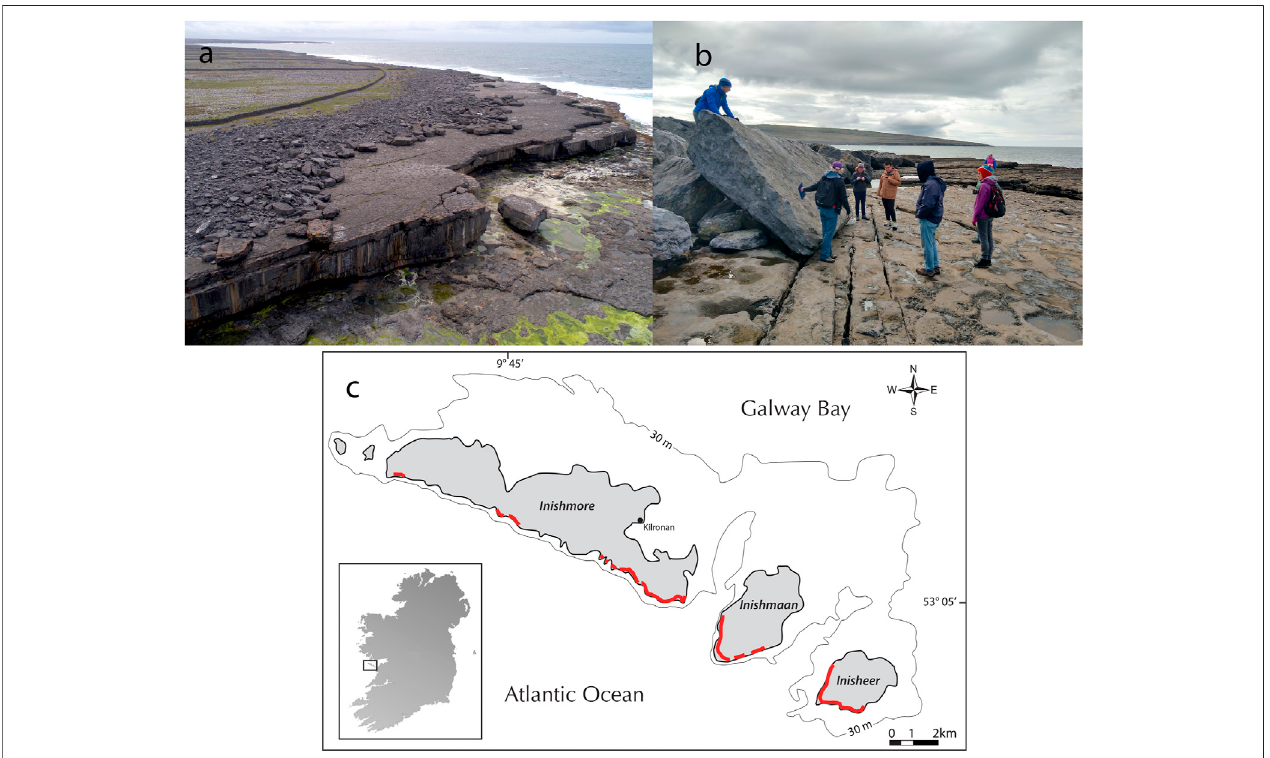
FIGURE 1 | Examples of CBD in Western Ireland. (A) linear boulder ridge (12 – 15 m elevation above high water and 50 – 60 m inland) on Inishmore, Aran Islands: a number of boulders in this ridge were relocated during recent storms; and the 620 t megagravel block on the lower platform (5 m elevation and 30 m inland) was also moved; (B) Boulder ridge face (4.5 m elevation and 17 m inland) on mainland (County Clare), east of the Aran Islands: the tilted block ( ∼ 36 t) was moved 10 m inland in recent storms; (C) Aran Islands, showing general locations of CBD (red). The 30 m bathymetric contour is also shown. Modi fi ed after Cox et al. (2012).